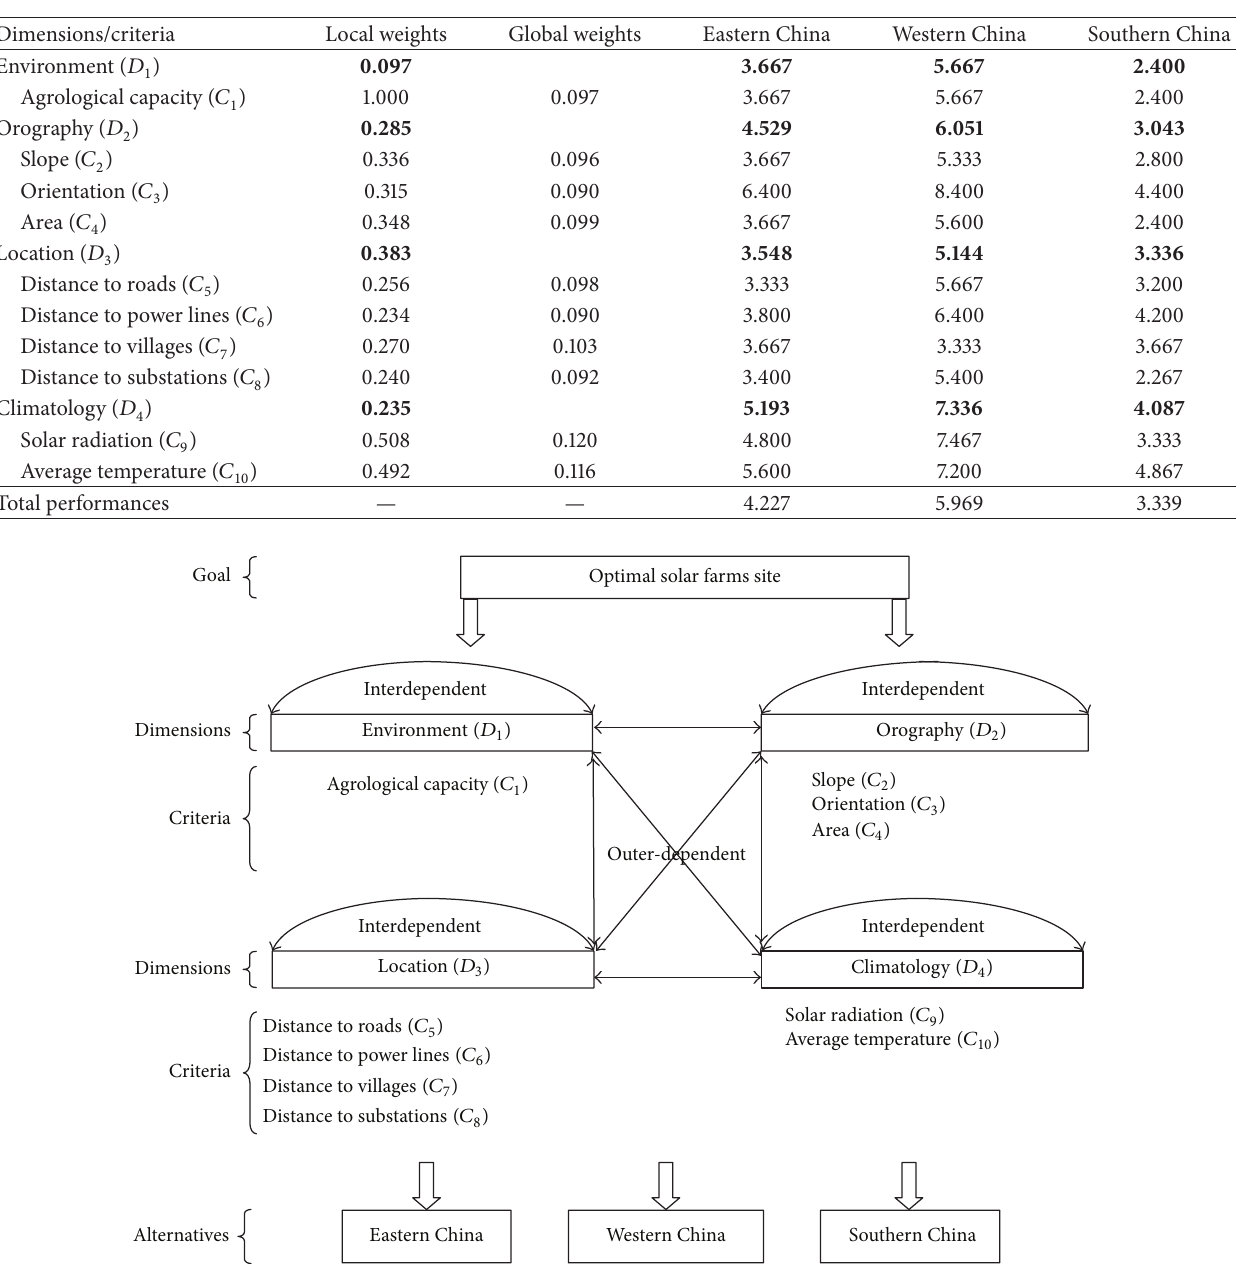
Table 8: Influential weights of solar farms site and performances of selected regions.